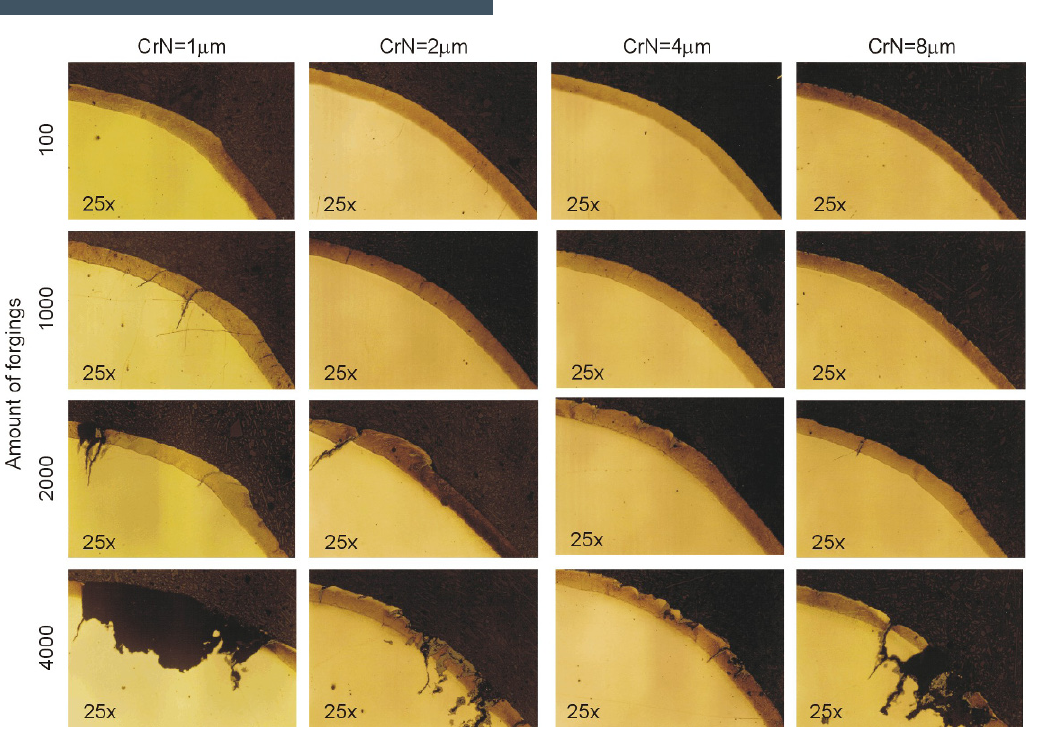
Figure 3. The results of metallographic studies for dies covered with hybrid layer “nitrided layer / CrN” with a different thickness of CrN coating.